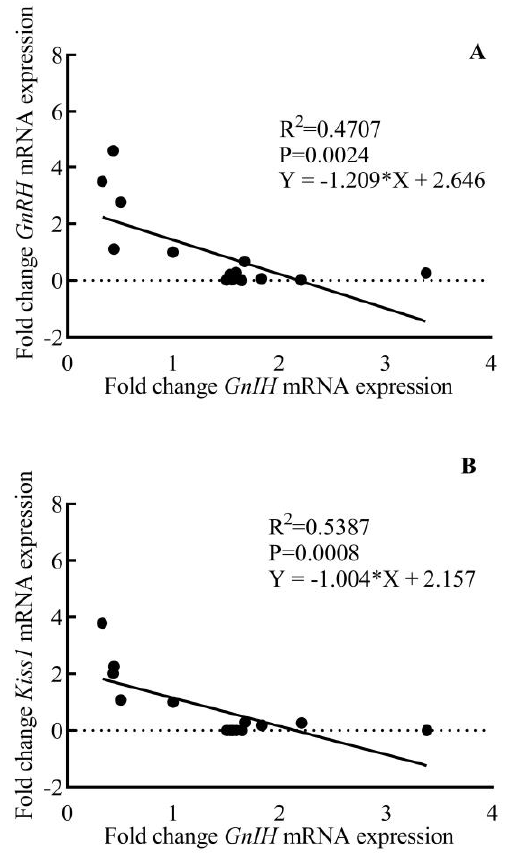
Figure 7. Inverse age-related correlation between hypothalamic fold change GnRH ( A ) and Kiss1 ( B ) expression with GnIH expression during pubertal development in male rhesus monkeys.